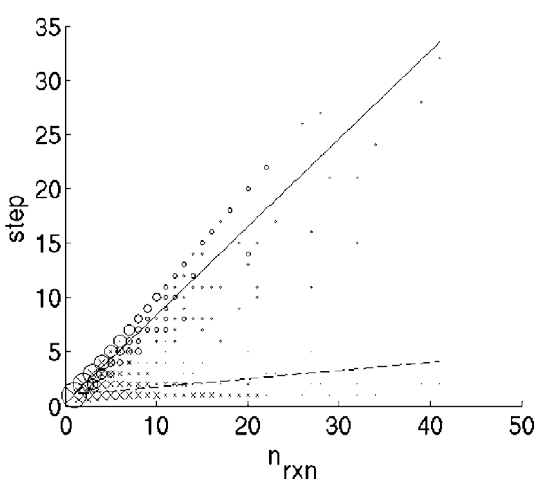
Figure 9. Comparison of lengths of the pathways and shortest distances of the targets from the core. The lengths of the pathways are represented by circles and solid line, while the shortest distances of the targets from the core are represented by crosses and dotted line.